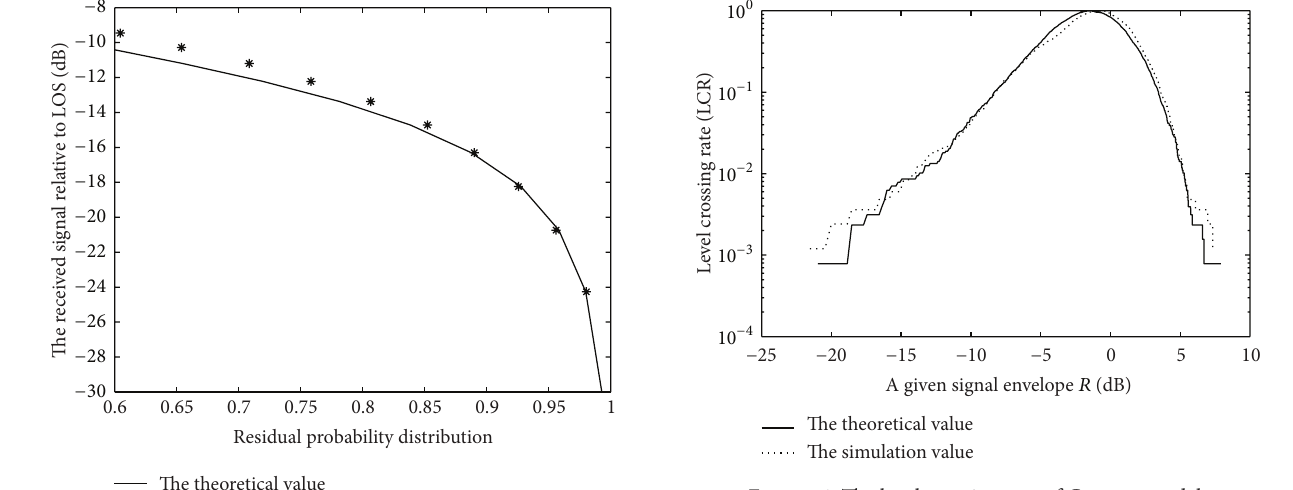
Figure 4: The level crossing rate of Corazza model.